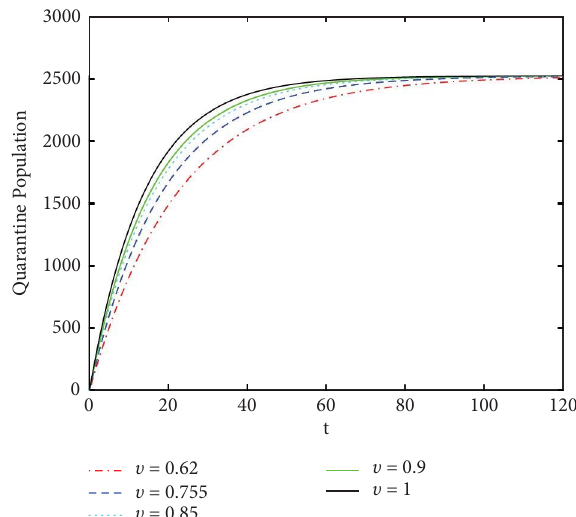
Figure 17: Te dynamics of quarantine human population for various fractal orders π and for fractional order υ � 0 . 5.